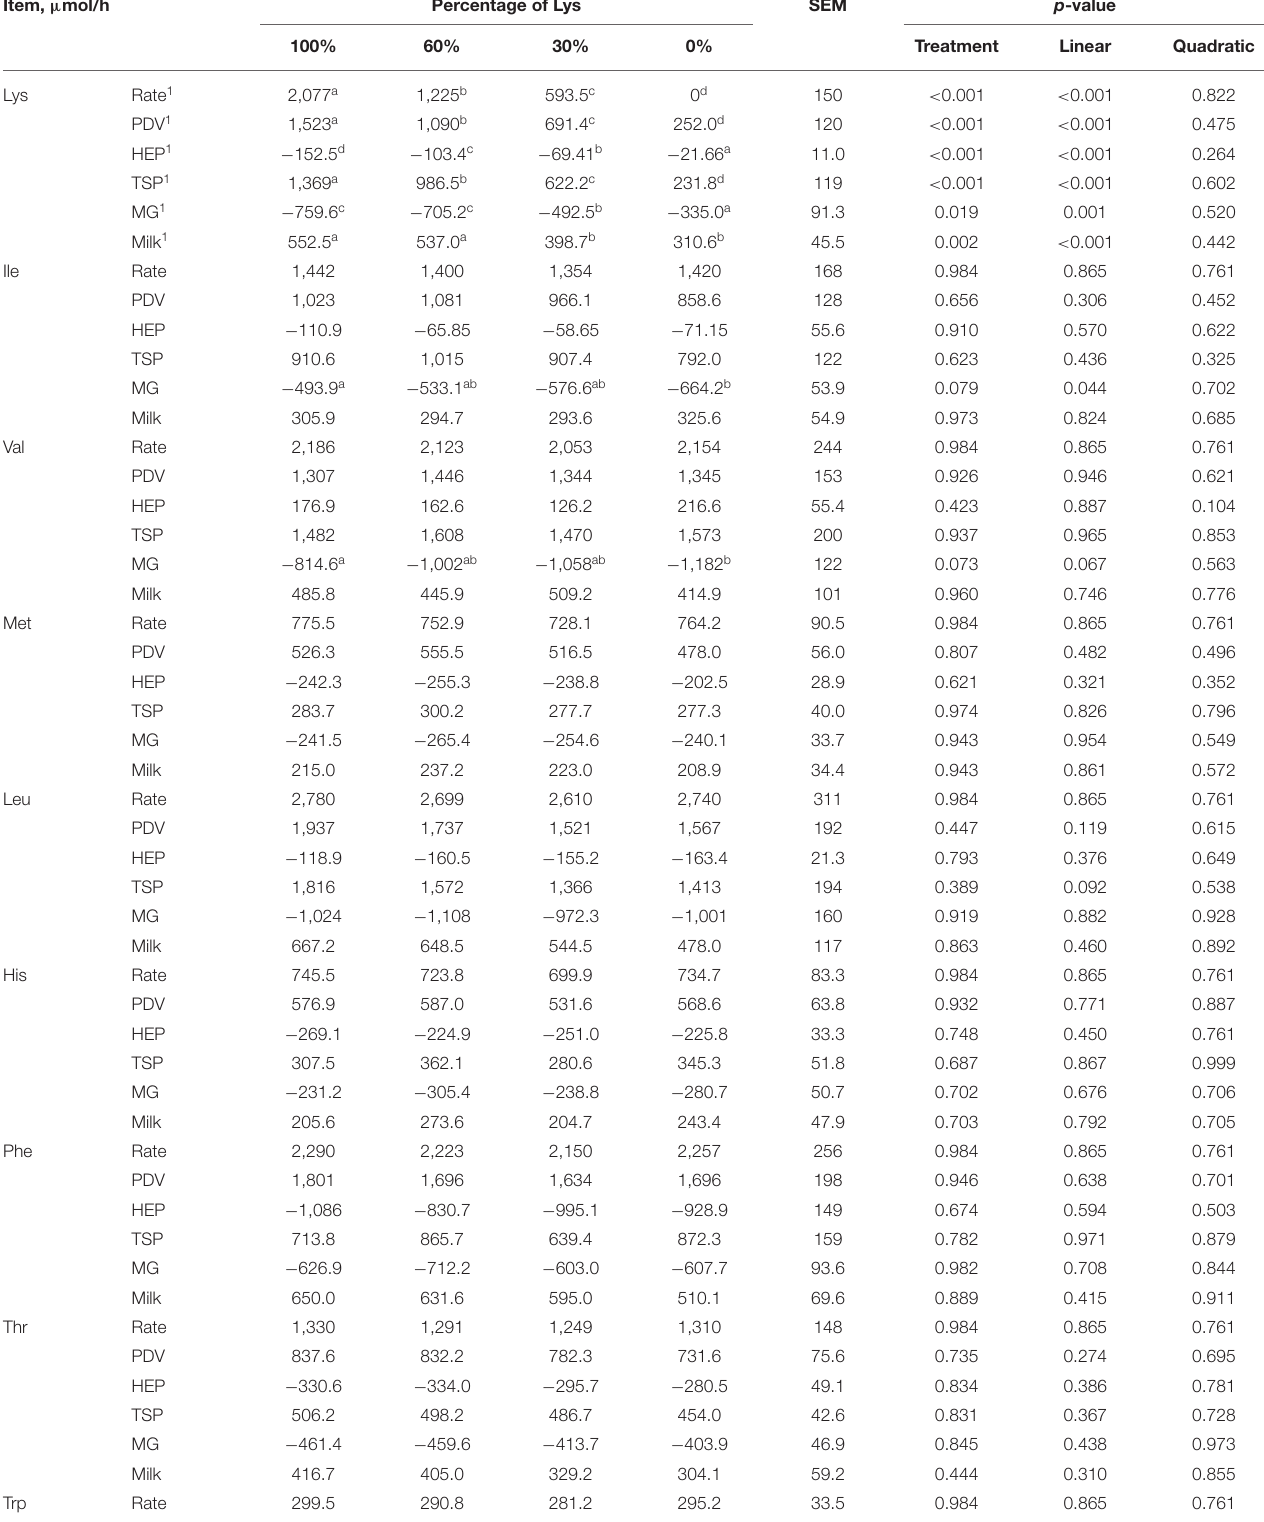
TABLE 7 | Effects of graded removal of Lys from the AA mixture infused into abomasum on splanchnic and mammary net fluxes of amino acids in lactating goats. Item, µ